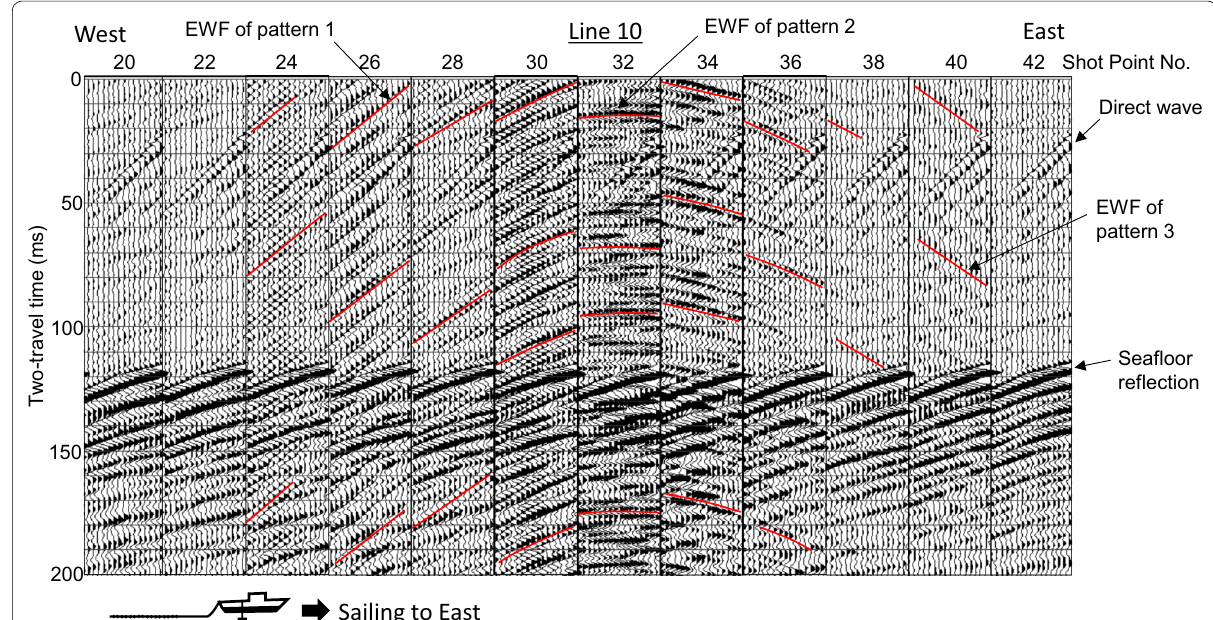
Fig. 8 The EWF observed in the shot records of line 10. Three EWF patterns can be observed around shot point 32: EWF of pattern 1, EWF of pattern 2, and EWF of pattern 3. The survey boat sailed toward the east on this line